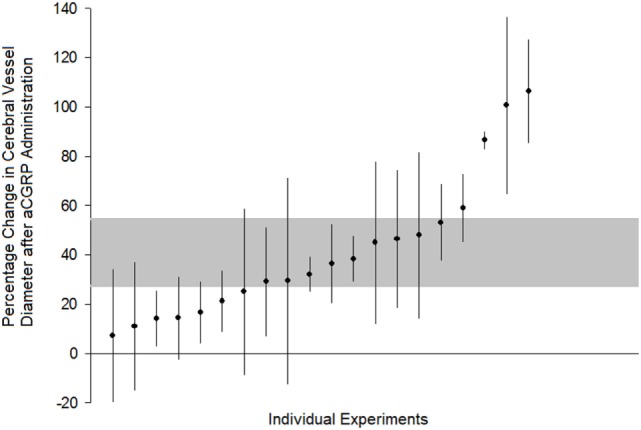
Comparison of individual experiments ranked according to the effect of alpha calcitonin gene-related peptide on change in cerebral vessel diameter. Vertical error bars represent 95% confidence intervals for the individual estimates while the gray area represents the 95% interval for the grouped (all studies) estimate. Percentage change is in comparison to post-subarachnoid hemorrhage diameter or control values, depending upon how the original publication reported results.